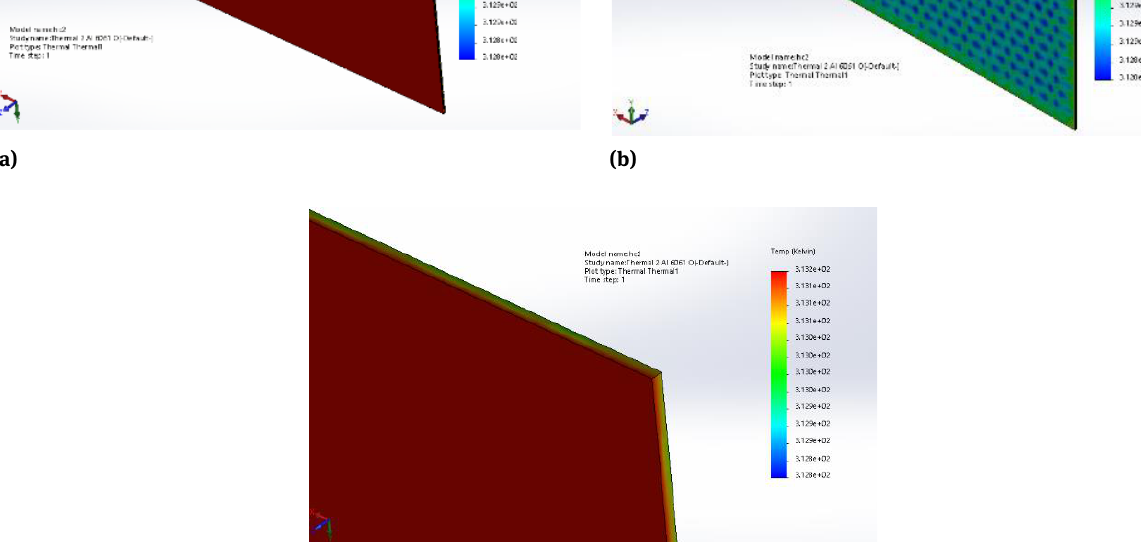
Figure 19: Result of the thermal simulation for the general honeycomb: (a) outer surface, (b) inner surface, and (c)